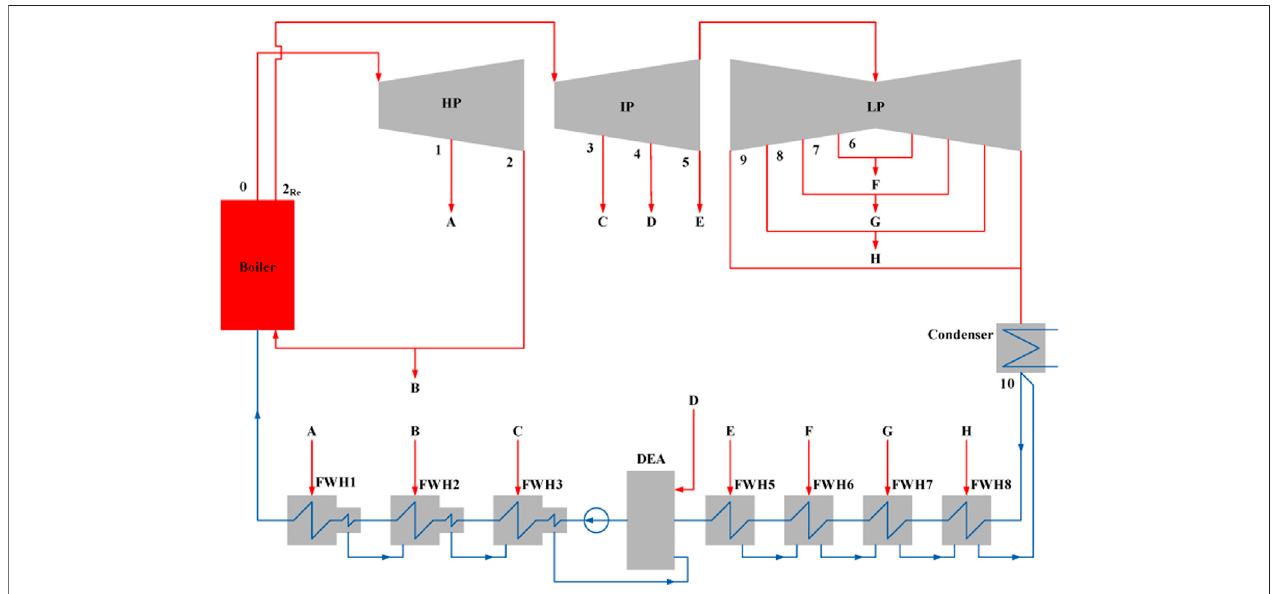
FIGURE 1 | Schematic diagram of a typical 300 MW regenerative Rankine cycle power plant with seven feedwater heater (FWH) and one deaerator.